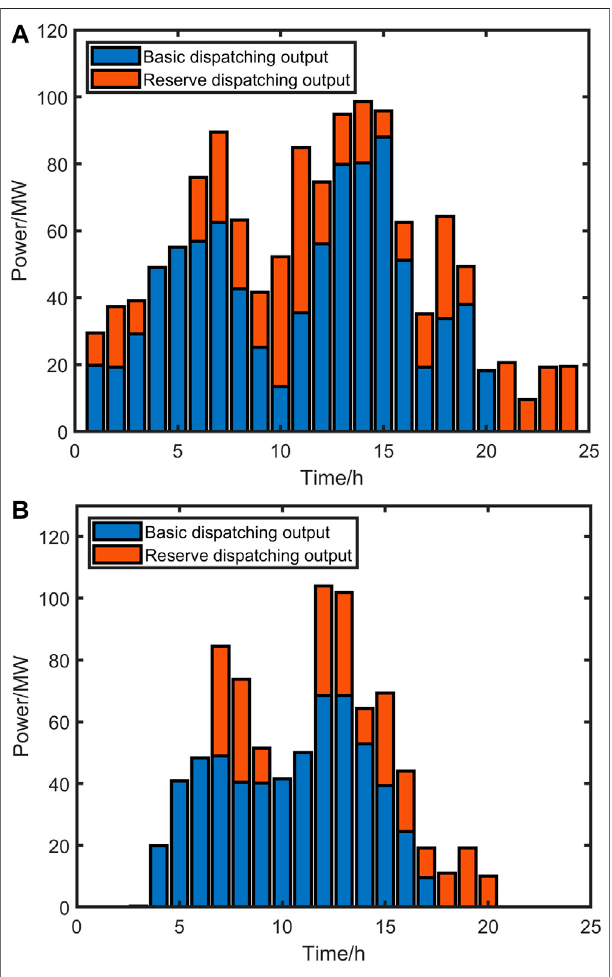
FIGURE 8 | The power of basic dispatching and reserve of G5. (A) Scenario 1. (B) Scenario 2.